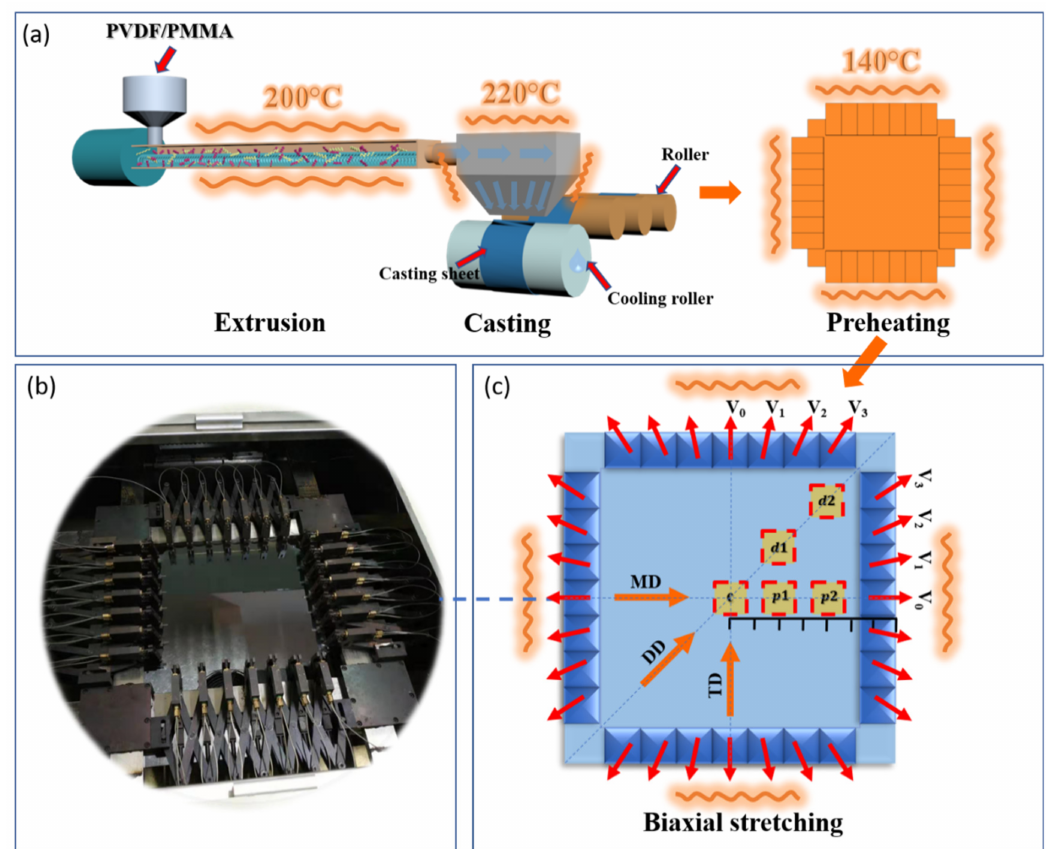
Figure 1. ( a ) Schematic diagram of extrusion, casting, preheating and biaxial stretching processing. ( b ) Photo of the biaxially stretching device. ( c ) Schematic diagram of the film during stretching.